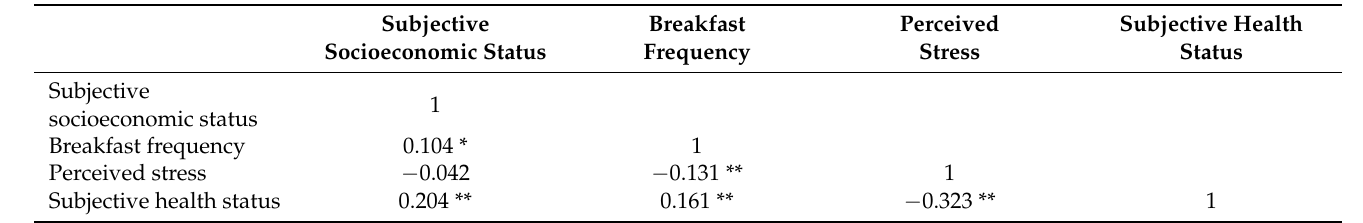
Table 2. Correlations between variables.